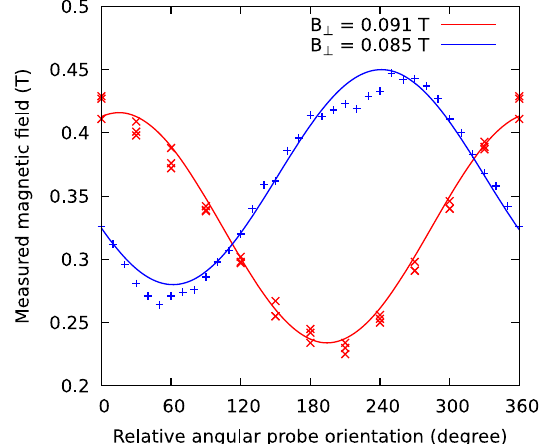
5. Results of experimental measuring of a transverse magnetic field at the axis of the steel helix of a square cross section. The different curves correspond to different axial positions of the probe. The transverse component of the field is determined as an amplitude of the sinlike dependency of the probe signal on its angular